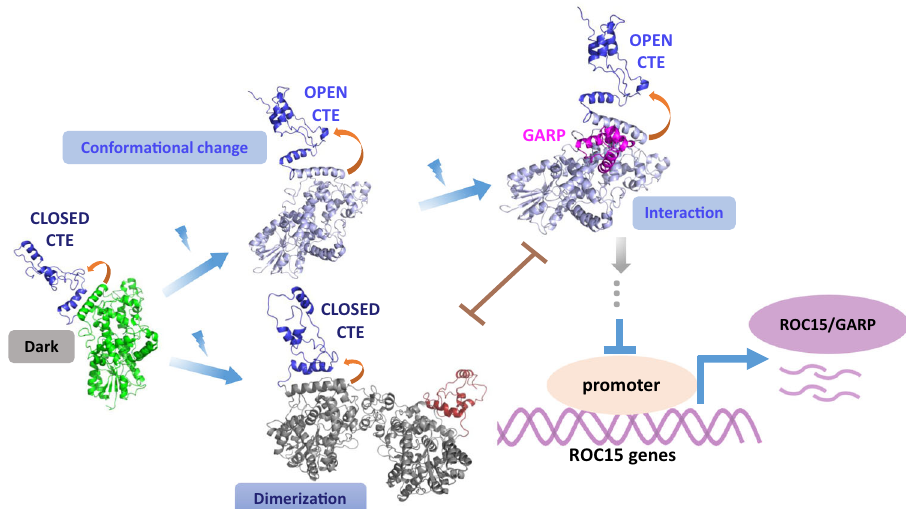
Fig. 5 Proposed model of the molecular functional mechanisms of Cra CRY. The interplay among blue-light-induced conformational change in Cra CRY, dimerization, and interaction with ROC15 are depicted by the arrows. The green image shows the inactivated, closed Cra CRY monomer, whereas the blue image shows the monomer Cra CRY in the open state. The red and gray images show the monomer units in the dimeric Cra CRY. The purple image indicates the GARP motif structure docked to the activated Cra CRY. Cra CRY structures in monomeric and dimeric states and the Cra CRY – ROC15(GARP) complex structure were re fi ned or validated against SAXS pro fi